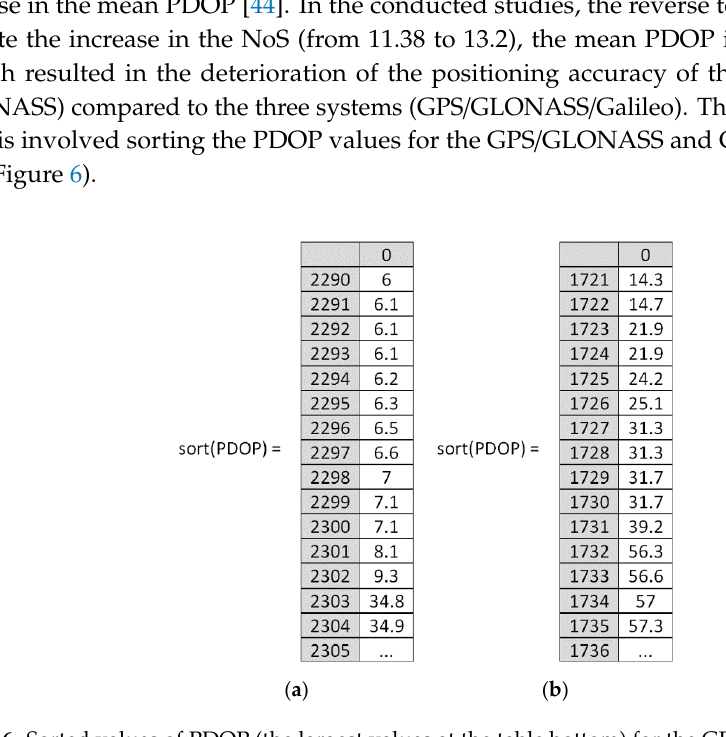
Figure 6. Sorted values of PDOP (the largest values at the table bottom) for the GPS/GLONASS ( a ) and GPS/GLONASS/Galileo measurements ( b ).